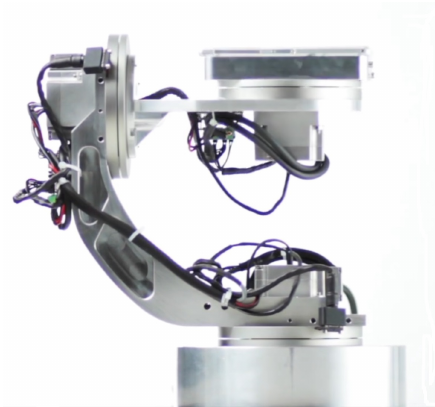
Figure 1. Photo of the three-axis